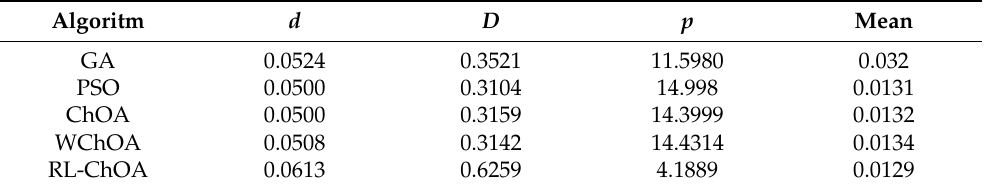
Table 11. Comparison of tension/compression spring